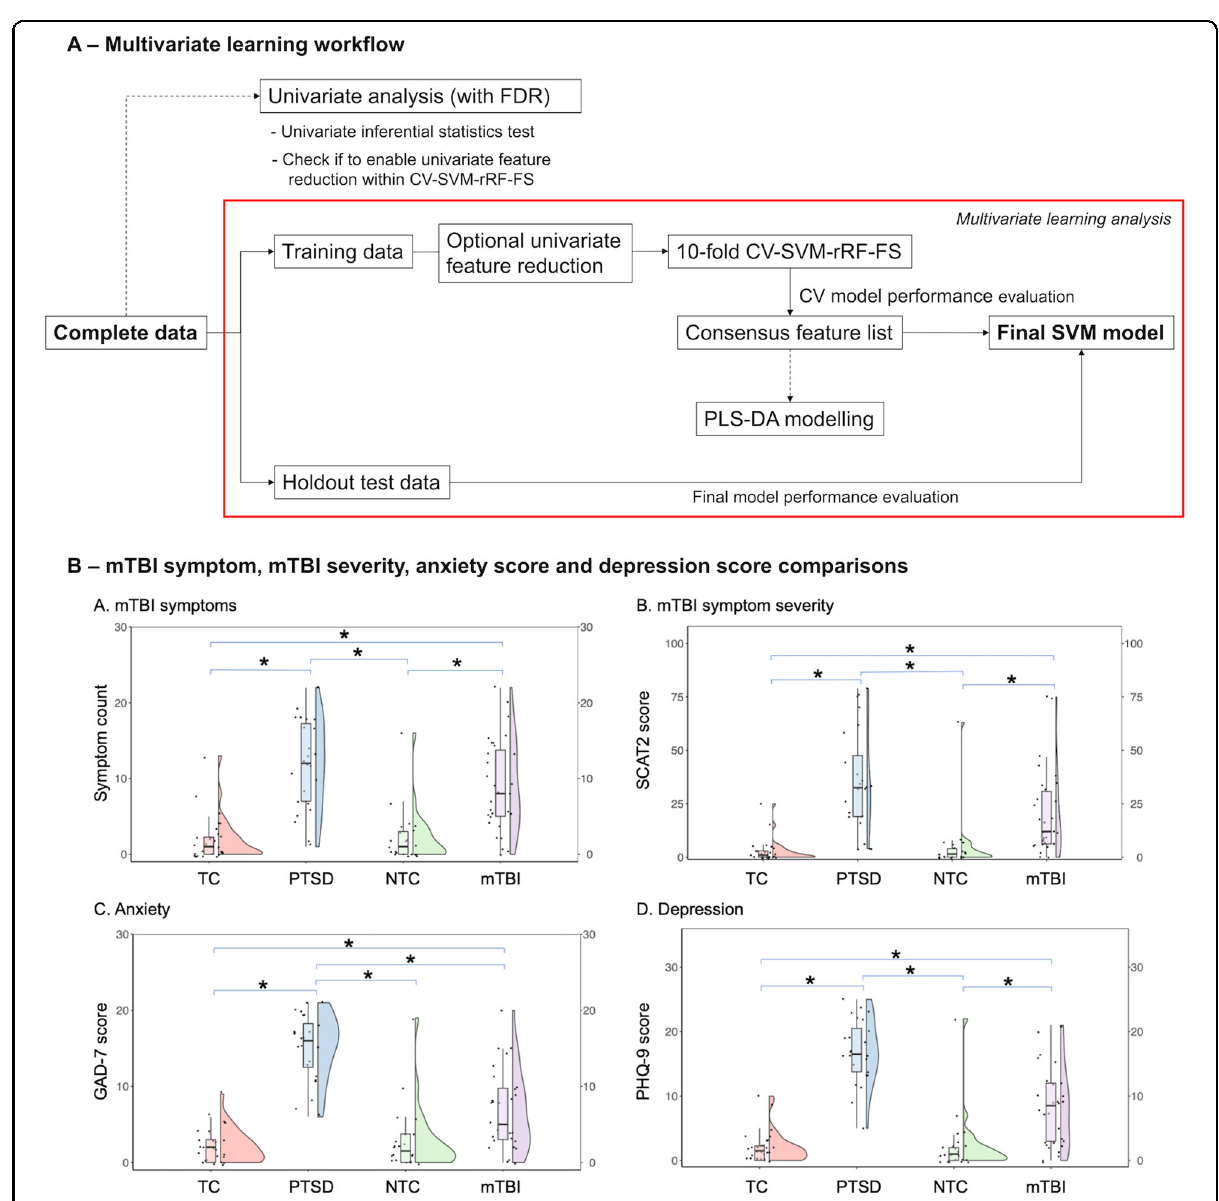
Fig. 1 Overall downstream informatics work fl ow and symptom analysis. A A fl owchart showing overall downstream informatics analysis work fl ow. B Concussion, anxiety and depression symptom pro fi les overlap in PTSD and mTBI. Rain cloud plots showing mTBI symptom number, mTBI severity, anxiety and depression score for the mTBI, PTSD, TC and NTC groups. Raw data (dots), boxplot and probability distribution are plotted. No statistical difference was observed for PTSD and mTBI in mTBI symptoms. PTSD participants (without head injury) reported signi fi cantly higher mTBI symptom severity than the mTBI participants. Although PTSD participants exhibited signi fi cantly higher anxiety and depression scores than the mTBI participants, both PTSD and mTBI groups scored signi fi cantly higher than both controls groups in the two scales. * = statistically signi fi cant ( p â €‰ <â € ‰ 0.05) differences based on the ANOVA with Tukey post-hoc test. FDR false discovery rate, CV-SVM-rRF-FS support vector machine and recursive random forest feature selection with cross validation, PLS-DA partial least squares discriminate analysis, NTC non-trauma control, TC trauma-exposed control, SCAT2 Sports Concussion Assessment Tool 2, GAD-7 Generalised Anxiety Disorder 7, PHQ-9 Patient Health